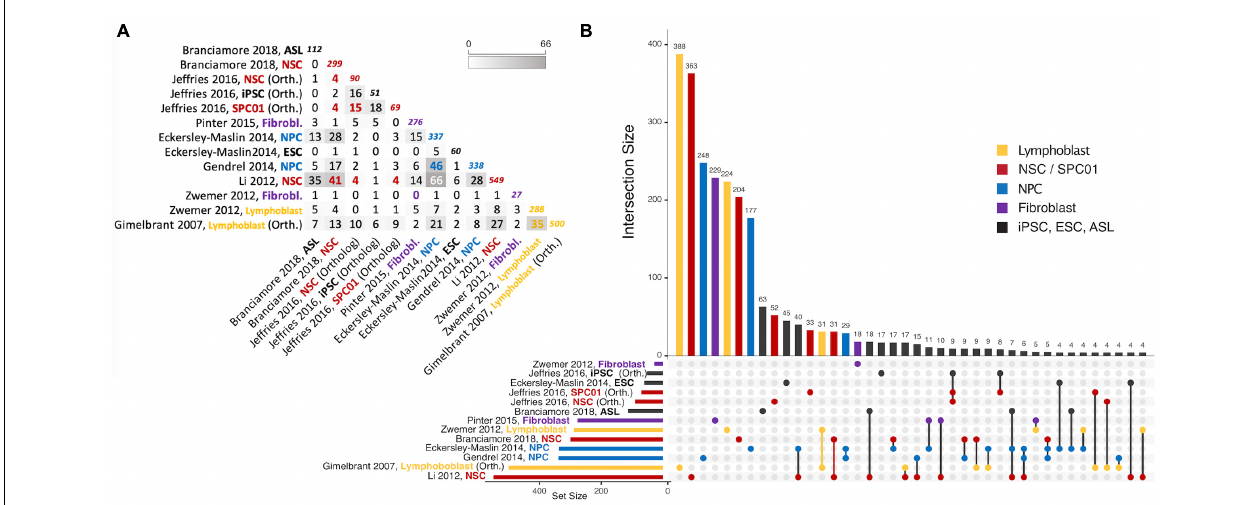
FIGURE 3 | Intersections of autosomal gene collections identified as random monoallelically expressed in the genome-wide studies described in Table 2 (except Jeffries et al., 2012, which is not publicly available). (A) Half-matrix showing all pairwise intersections. (B) Upset plot (Conway et al., 2017) showing gene collection intersections of the same studies. The lower part of the panel has a horizontal bar plot showing the number of elements on each study collection, and a right section with a dot matrix. Each dot represents unique gene intersections, i.e., each gene is represented only once in the dot matrix. The upper vertical bar plot is related to the dot matrix, showing the number of unique genes in each intersection (for instance, there are 500 MAE genes in the Gimelbrant et al. (2007) dataset, but only 388 of those are uniquely present in that dataset; similarly, the Li et al. (2012) dataset shares more than 40 MAE genes with Eckerley-Maslin (2014) NPC dataset, but those 40 are uniquely shared between those two sets). Intersections of size smaller than 4 are not represented. For a complete description of the intersections and gene listing, see the Supplementary File provided with this review. ASL, Astrocyte-like cells; NSC, Neural stem cells; NPC, Neural progenitor cells; ESC, Embryonic stem cells; SPC01, Clonal Neural stem cells (before epigenetic reprogramming); iPSC, induced Pluripotent stem cells after epigenetic reprogramming of SPC01. Note that “NPC” on Jeffries et al. (2016) are derived from iPSC. Colors represent instances where a different cell/tissue type was studied more than once. To obtain intersections, gene ids were manually curated for immediate inconsistencies (e.g., gene name-to-date conversions when data was originally provided in microsoft excel format). All gene sets were then parsed with the gprofiler2 R package (Raudvere et al., 2019) for gene id consistency, using transcript ids as query